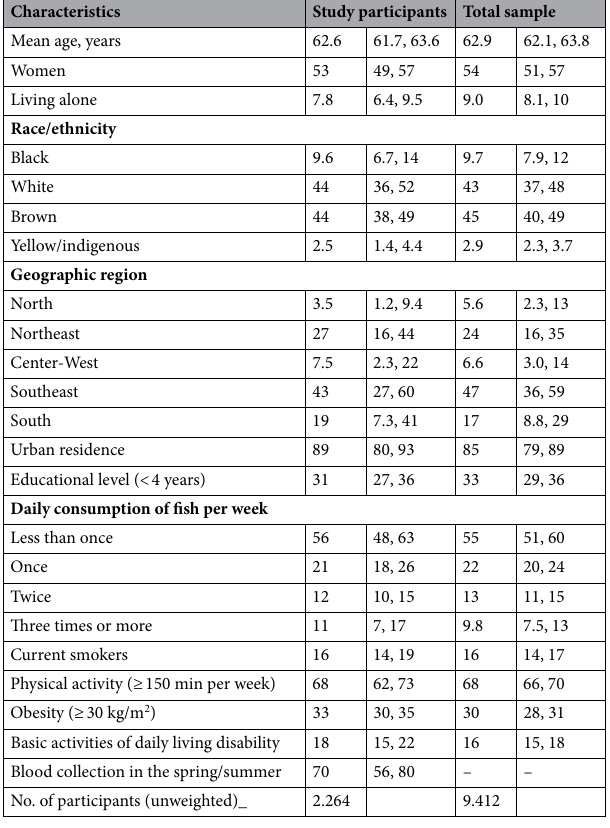
Table 1. Characteristics of the participants included in the present study compared to those from the whole baseline sample of the Brazilian Longitudinal Study of Aging (ELSI), 2015–16. All results are expressed in percentages and 95% confidence intervals, except when specified. The means and percentages were estimated considering the sample parameters and the weights of the individuals in the